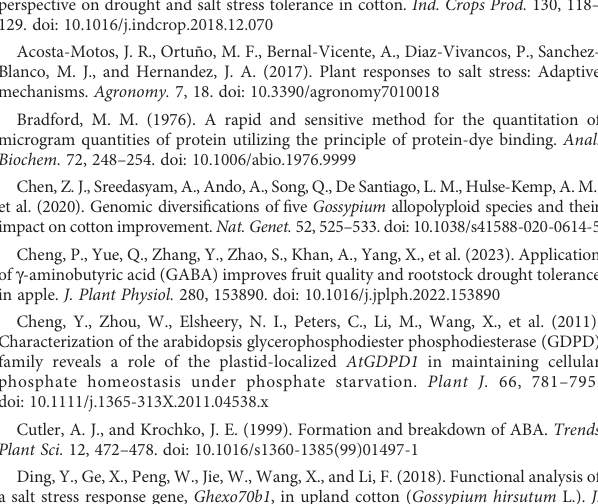
SUPPLEMENTARY FIGURE 1 Annotation statistics of GO secondary nodes for differentially expressed genes. The horizontal coordinate is the GO classi fi cation, the left side of the vertical axis is the percentage of the numberof genes, and the right side is the number of genes. SUPPLEMENTARY FIGURE 2 ResultsofGOenrichmentanalysis.TheverticalcoordinateistheenrichedGO term, the horizontal coordinate is the enriched q value, and the numbers on the bars are the number of differential genes. The different colors represent biological processes and cellular components. SUPPLEMENTARY FIGURE 3 Graph of KEGG enrichment statistics for differentially expressed genes. The vertical axis indicates the pathway name, the horizontal axis indicates the rich factor, the size of the dots indicates the number of DEGs, and the color of the dots corresponds to the q-value. SUPPLEMENTARY FIGURE 4 Annotation statistics of GO secondary nodes for differentially expressed proteins. The horizontal coordinate is the GO classi fi cation, the left side of the vertical axis is the percentage of the numberof genes, and the right side is the number of genes. SUPPLEMENTARY FIGURE 5 Results of GO enrichment of differentially expressed proteins. The vertical coordinateis the enriched GO term, the horizontal coordinateis the enriched q value, and the numbers on the bars are the number of differential genes. The different colors represent biological processes and cellular components. SUPPLEMENTARY FIGURE 6 Plot of statistical results of differential protein KEGG enrichment. The vertical axis indicates the name, the horizontal axis indicates the Rich factor, the size of the dots indicates the number of differentially expressed proteins, and the color of the dots corresponds to the different q-value